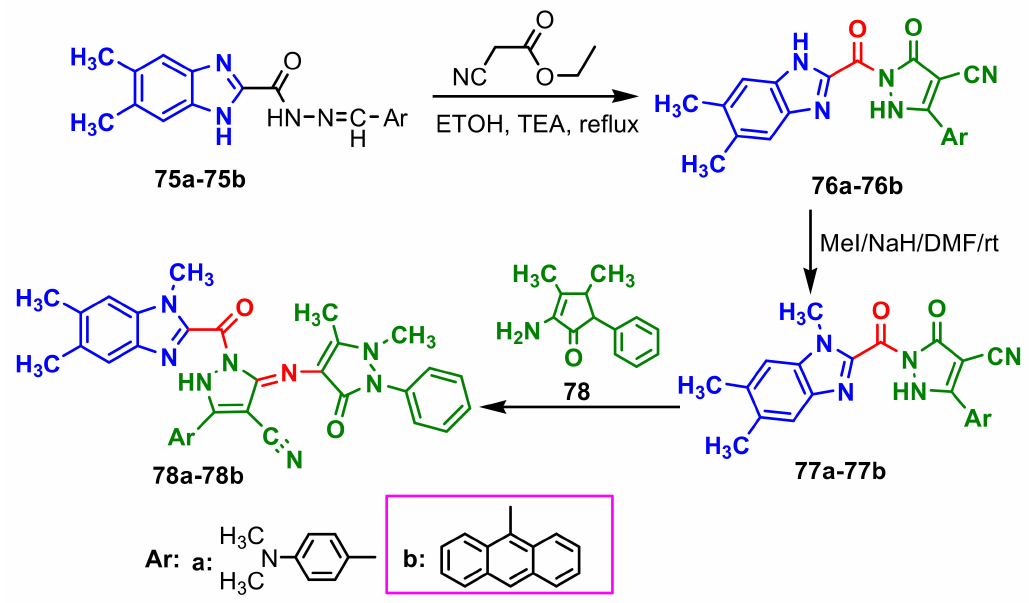
Table 7. The antimicrobial activity of the compounds 76a , 76b , 77b , 78a , 78b . Inhibition Zone Diameter (mm/mg Sample) Microorganism 76a 76b 77b 78a 78b Amoxicillin Bacillus cereus 10 7 9 7 10 22 Bacillus subtilis - - 10 7 9 25 Staphylococcus aureus 10 10 18 10 18 16 Escherichia coli 7 12 8 8 - 22 Pseudomonas aeruginosa 10 9 11 11 13 30 Salmonella typhimurium 40 - - - 11 20 Benzimidazolo–pyrazole compounds 80a – 80h and 81a – 81h were synthesized from the reaction of chalcones 79a – 79h with phenylhydrazine and 2,4-dinitrophenylhydrazine, respectively (Scheme 21) [75]. All compounds were screened for their antimicrobial activi- ties against E. coli , P. aeruginosa , S. aureus , B. subtilis , C. albicans and A. niger (Table 8). The best antimicrobial activities of the compounds are marked in green in Table 8. It is observed that compounds 80b and 80h showed a good antibacterial activity against all the strains tested, and compounds with 2,4-dinitrophenylhydrazine had better antifungal activity than the antibacterial one, e.g., compounds 81b and 81f . Only compound 80a showed significant antitubercular activity at the concentration of 100 µ g mL − 1 compared with the standard drug,